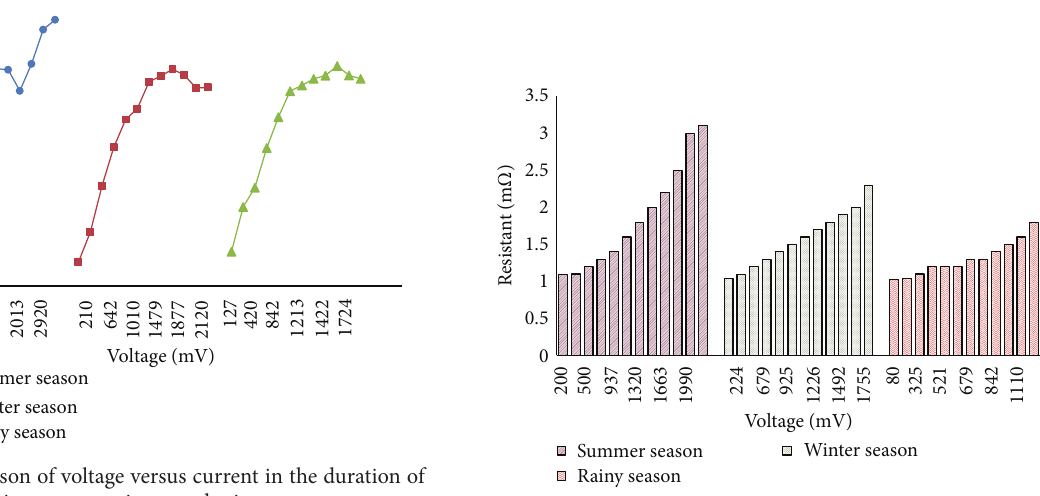
Figure 10: Comparison of voltage versus current in the duration of 2.00–4.00 pm in summer, winter, and rainy season.